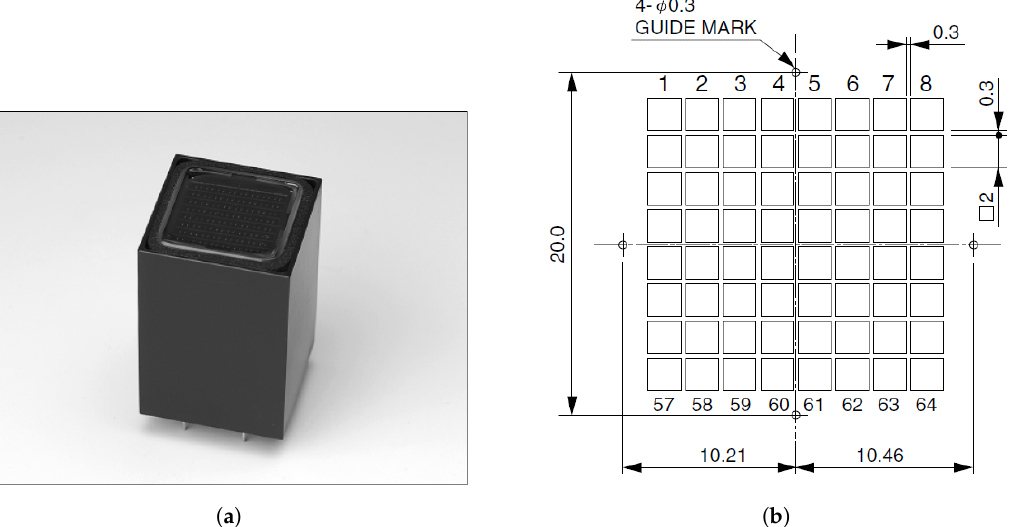
Figure 3. Multi-anode photon-multiplier tube (MaPMT) by Hamamatsu. ( a ) H7546B MaPMT [30]; ( b ) Sensing plane containing 8 × 8 anode